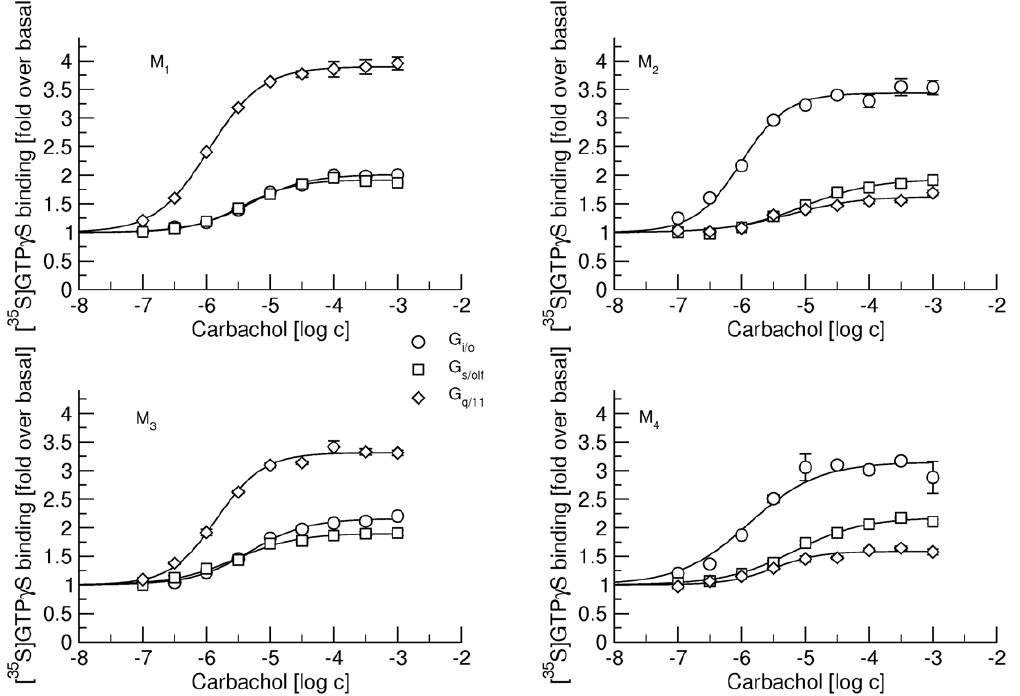
Figure 1. Stimulation of [ 35 S]GTP c S binding by carbachol. [ 35 S]GTP c S binding to G i/o (circles), G s/olf (squares) and G q/11 G-proteins (diamonds) via M 1 (upper left), M 2 (upper right), M 3 (lower left) and M 4 (lower right) receptors by increasing concentrations (abscissa, log M) of carbachol is expressed as fold over basal (ordinate). Data are means 6 S.E.M of values from 3 experiments performed in quadruplicates. Curves were fitted using equation 2 and results of fits are shown in Table 1.